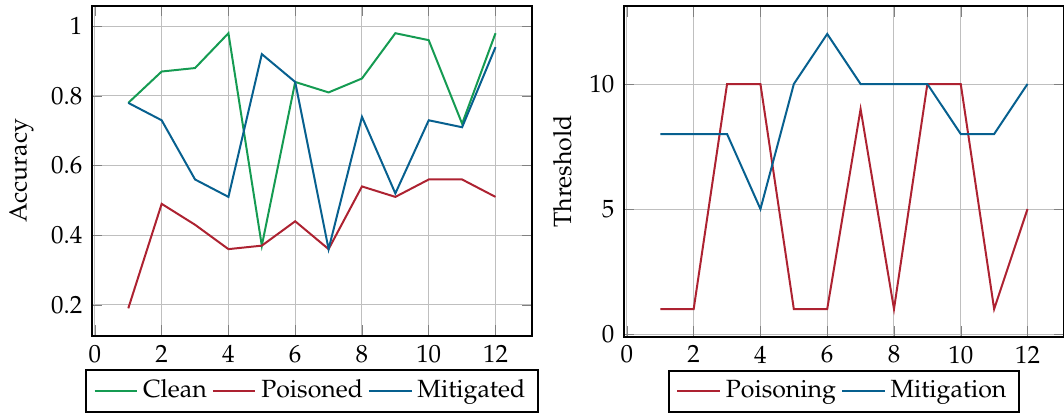
Figure 4. Dynamic Relabeling Results.